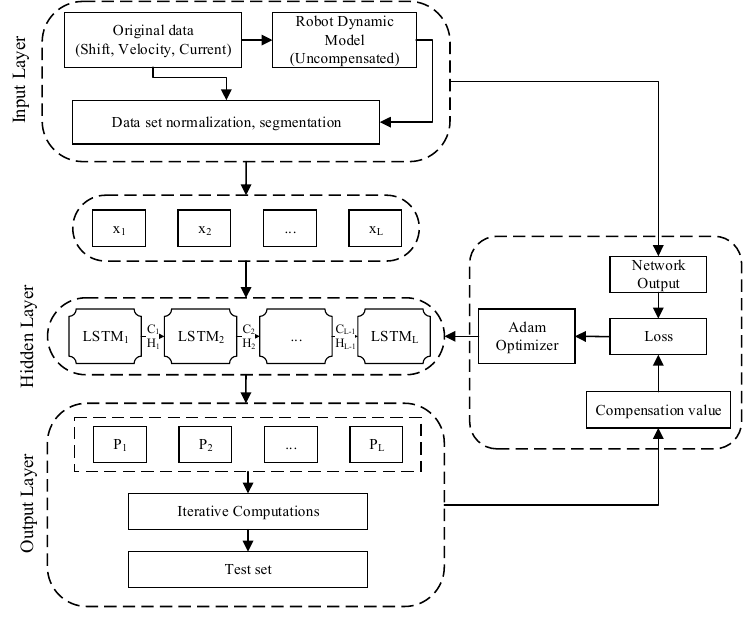
Figure 6. Pipeline of LSTM based robot dynamic compensation.